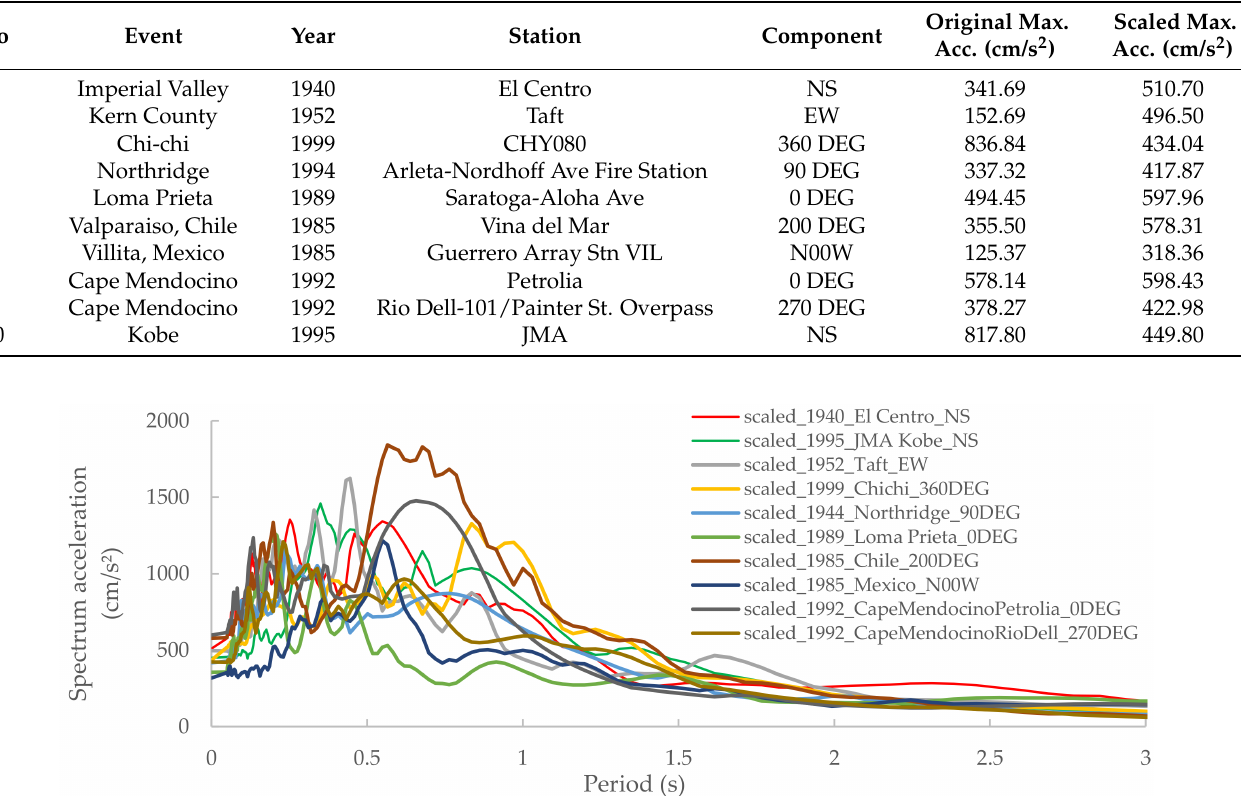
Figure 16. Acceleration response spectra (with 5% damping factor) of input earthquake